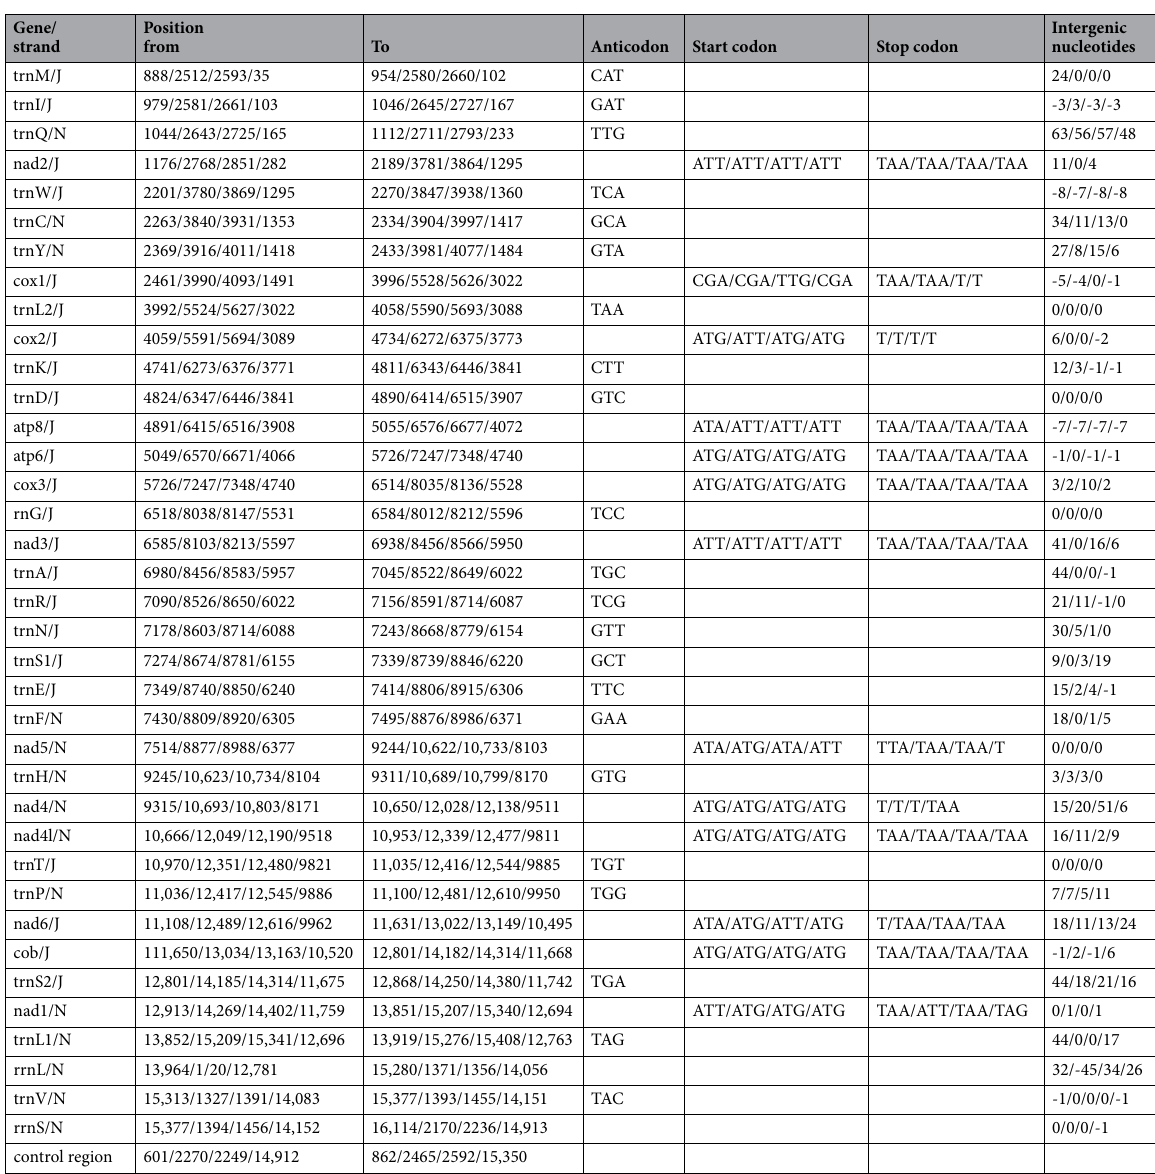
Table 2. Details on gene organization of four newly determined Lepidoptera mitogenomes. The order of the four species in the table is as follows: Oraesia emarginata/Actinotia polyodon/ Odontodes seranensis/Hyblaea puera . J and N refer to the majority and minority strand